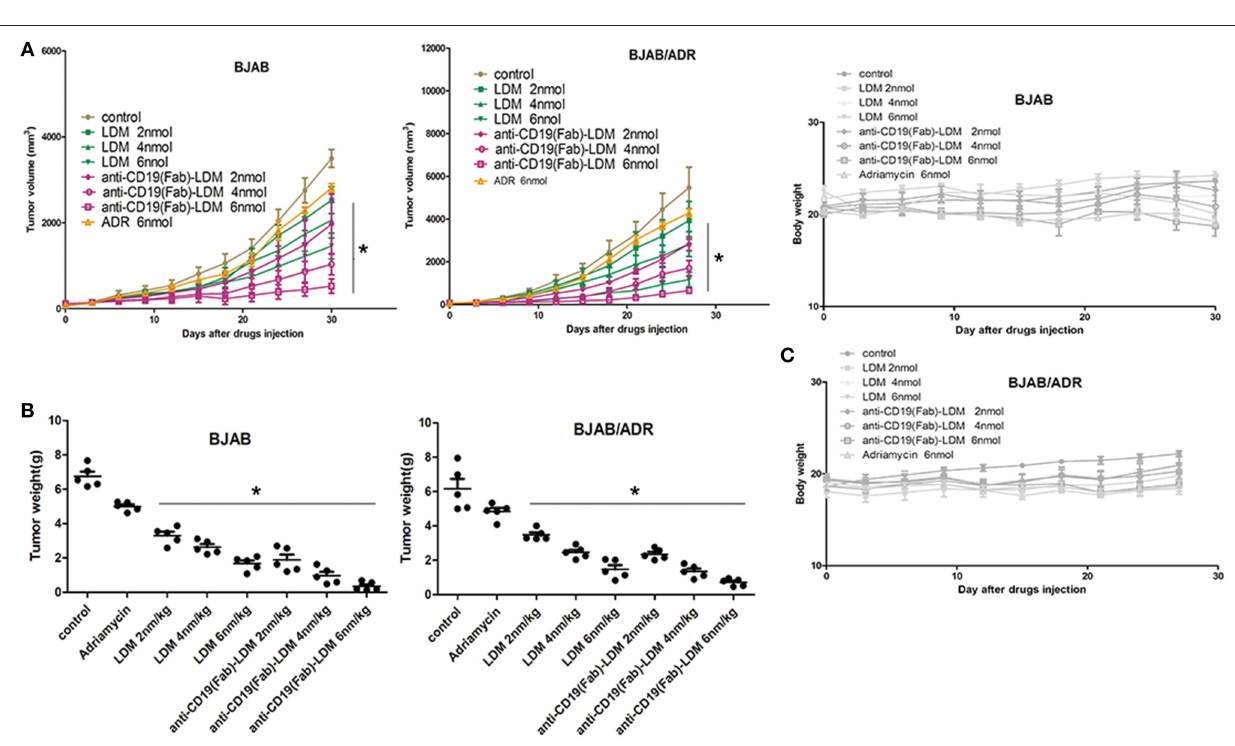
FIGURE 6 | Inhibitory effect of anti-CD19(Fab)-LDM on the growth of xenograft tumors. (A) Changes in tumor volume over time in BJAB and BJAB/ADR xenograft models ( n = 5). Tumor volume was measured once every 3 days. Mice in the anti-CD19(Fab)-LDM groups showed significant inhibition of tumor growth compared with the adriamycin-treated mice in the BJAB and BJAB/ADR xenograft models (* P < 0.05 compared to the control). (B) Tumor weights of excised BJAB and BJAB/ADR tumor tissues from different mice measured on the 28th day after implantation. The anti-CD19(Fab)-LDM had a significant antitumor effect on both the BJAB and BJAB/ADR xenograft models compared to the effects of adriamycin treatment alone in vivo , especially in the high dose group (* P < 0.05 compared to the control). (C) Body weight of mice with BJAB or BJAB/ADR cell xenografts after treatment. Weight was measured once every 3 days. There was no significant difference in body weight among the groups ( P > 0.05 compared with control